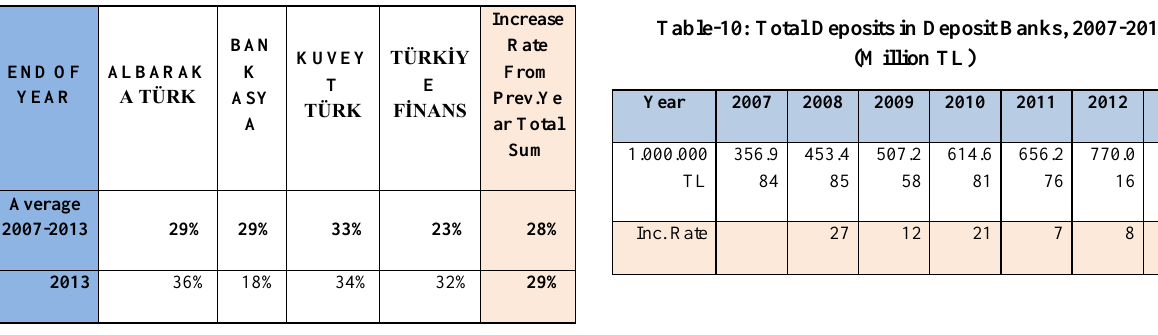
Table-8/b: Increase Rate from Previous Year at Total Funds Collected, 2007-2013 (1000TL)